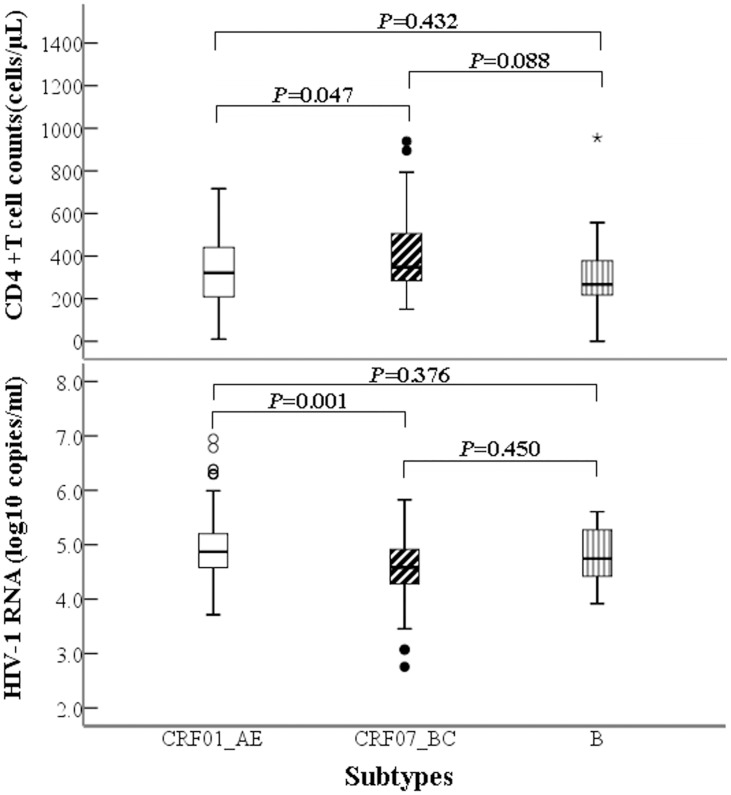
Comparisons of median baseline CD4+T cell counts and viral loads between three different subtypes.Median baseline CD4+T cell was lower in CRF01_AE infection than in CRF07_BC infection (P<0.05) while median baseline viral load was higher in CRF01_AE infection than in CRF07_BC infection (P = 0.001).